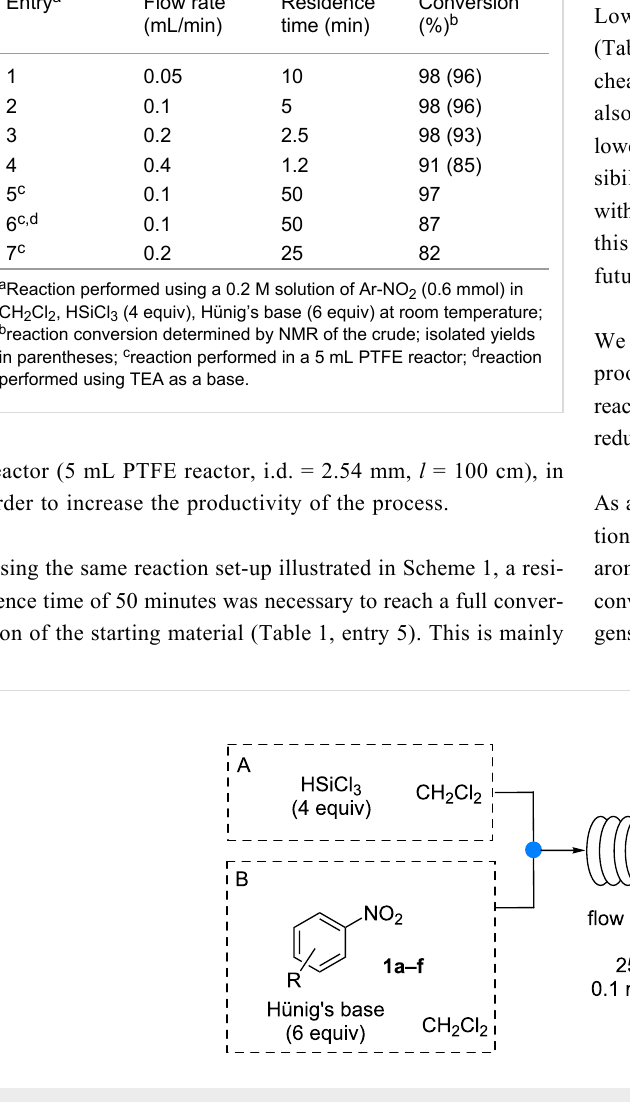
Table 1: Screening of reaction conditions. Entry a Flow rate